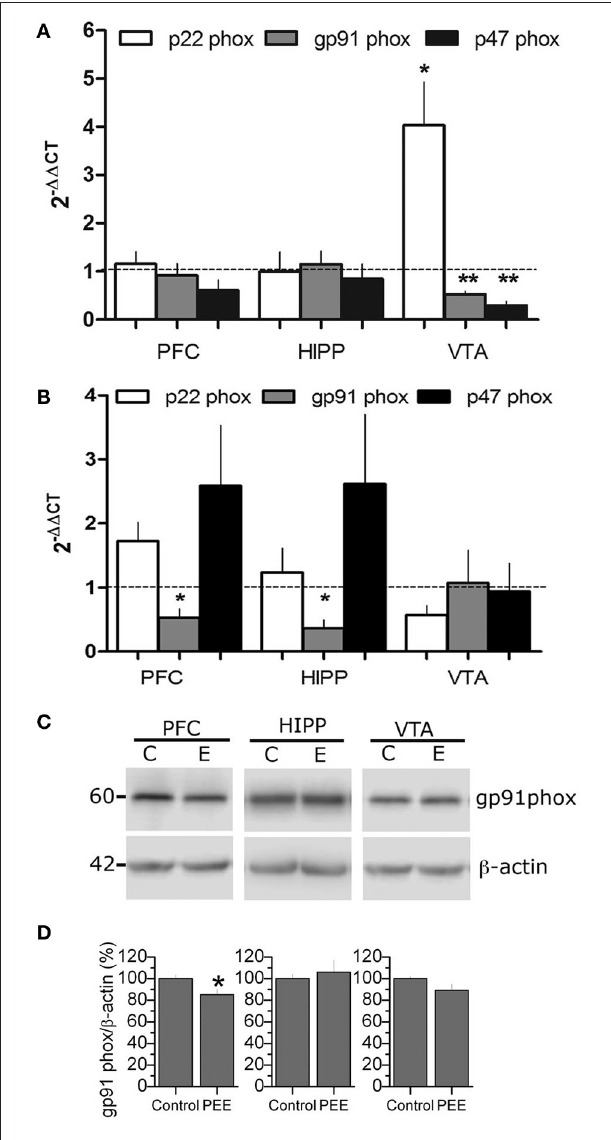
FIGURE 3 | PEE modifies NOX2 mRNA expression in rat brains. (A,B) Total RNA was obtained from the Prefrontal cortex, (PFC), Hippocampus (HIPP), and Ventral tegmental area (VTA) from Control or PEE rats of 21 (P21) (A) or 70 (P70) (B) days old and amplified using RT-qPCR. Data are expressed as a fold change between PEE vs. control gene expression. N = 3–4 litters. * P < 0.05, ** P < 0.01, paired Student’s t -test compared with 1. (C,D) Total protein samples were obtained from control and PEE rats at P70. Immunodetection was performed using a gp91 phox specific antibody and normalized to β